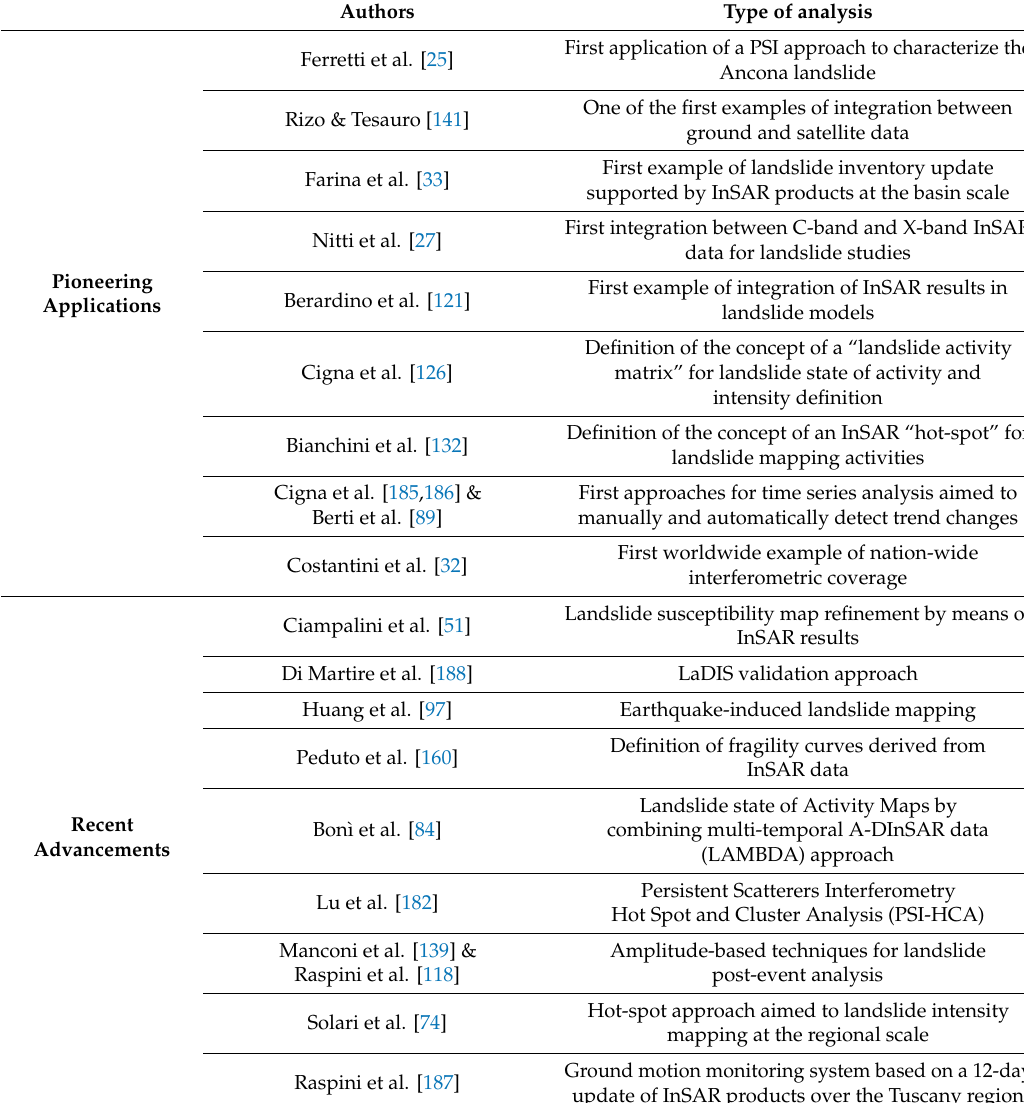
Table 2. Summary of the pioneering applications and of the most recent advancements of InSAR for landslide studies in